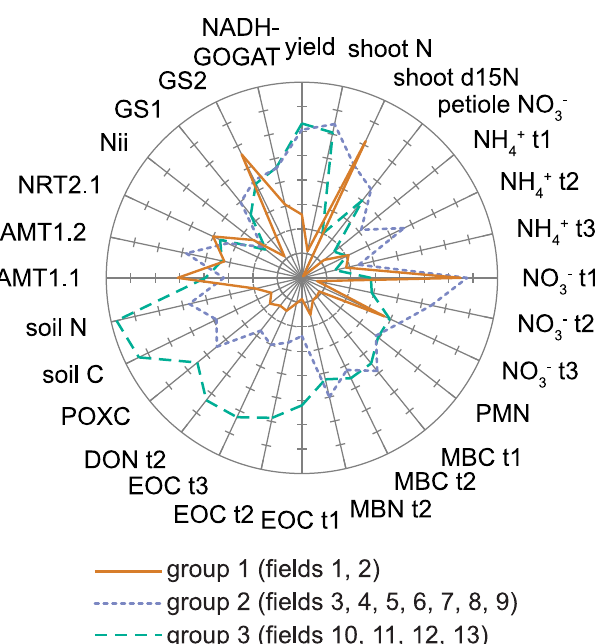
Fig 8. N cycling scenarios across organic fields in an intensively-managed agricultural landscape. Groups are based on k -means analysis of the 28 variables shown, including soil C and N pools, soil bioassays, tomato yield and N, and expression of key N metabolism genes in roots, across 13 fields in Yolo Co., California, USA. Each variable was normalized on a 0 – 1 scale, and then a mean for each cluster was calculated for each variable. N metabolism genes include: high-affinitity NH 4+ transporters AMT1.1 and AMT1.2; high-affinity NO 3- transporter NRT2.1; nitrite reductase Nii; cytosolic glutamine synthetase GS1; plastidic/chloroplastic glutamine synthetase GS2; glutamate synthase NADH-GOGAT.